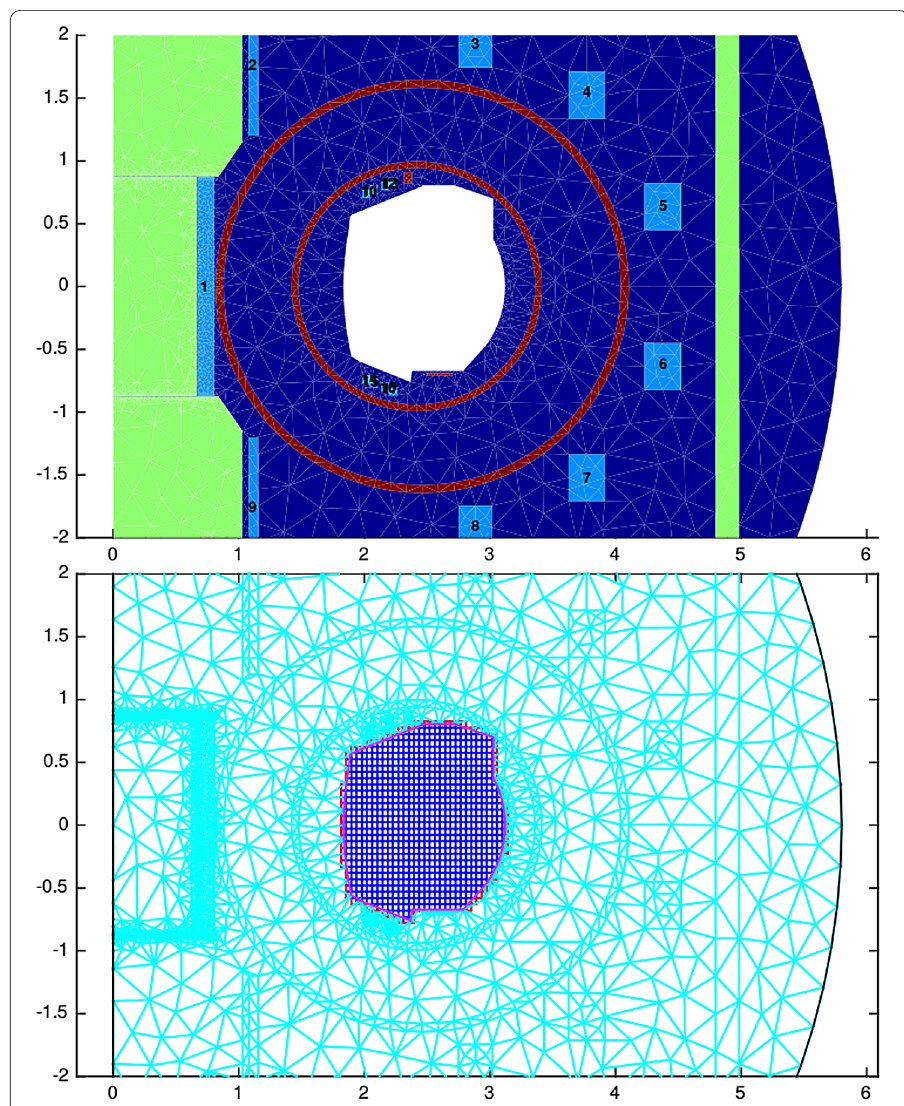
Figure 3 Composite meshes. Top: detail view for the WEST tokamak, with the iron core (green), the passive structures (red), the various coils (light blue) and the domain bounded by the limiter (white). Down: the composite meshes for the WEST